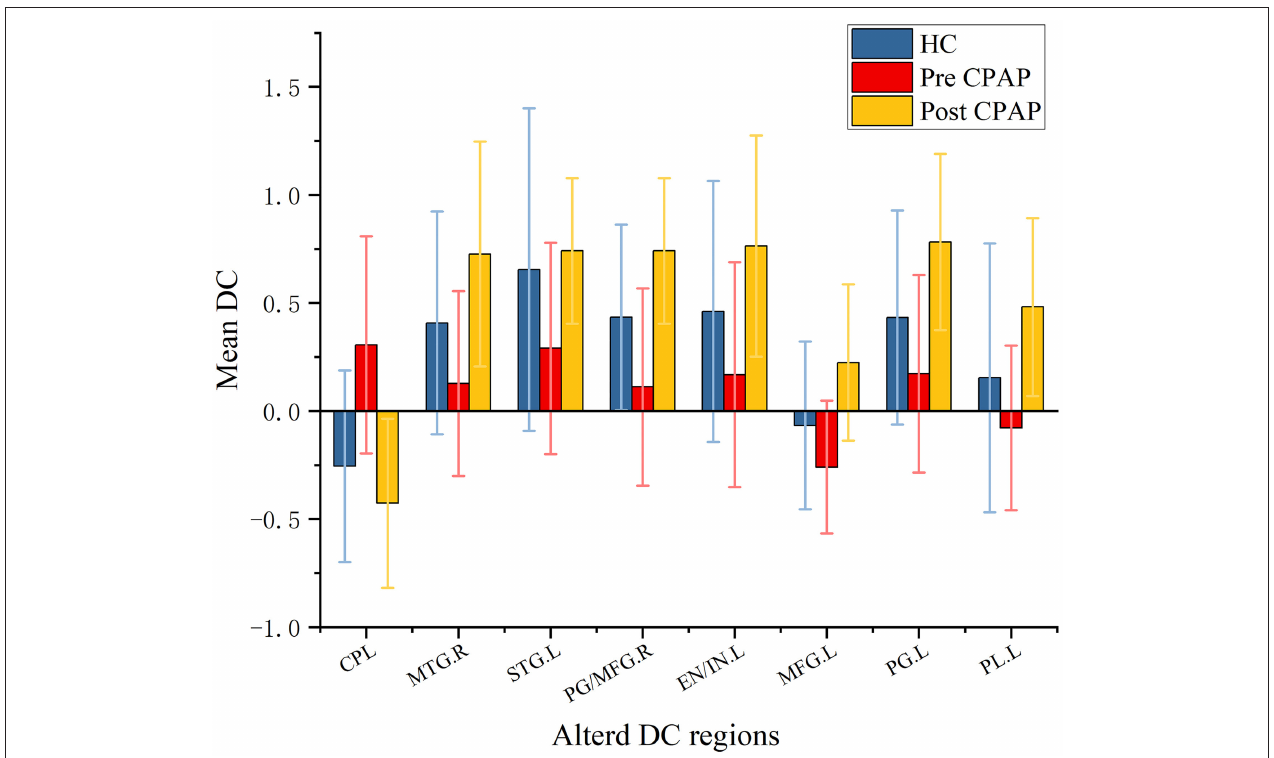
FIGURE 4 | Mean weighted DC signal values of HCs and pre- and post-CPAP OSA patients in altered regional brain areas before and after CPAP treatment. DC, Degree Centrality; pre-CPAP OSA, OSA patients before CPAP treatment; post-CPAP, OSA patients after CPAP treatment; HC, Healthy controls; CPL, Cerebellum posterior lobe; MTG, Middle temporal gyrus; STG, Superior temporal gyrus; PG, Precentral gyrus; MFG, Middle frontal gyrus; PL, Paracentral lobule; L, Left; R,